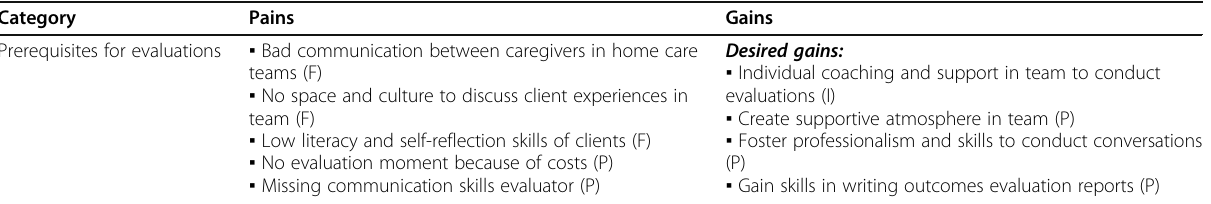
Table 8 Identified pains and (desired) gains for ‘ prerequisites for evaluating ’ Category Pains Gains Prerequisites for